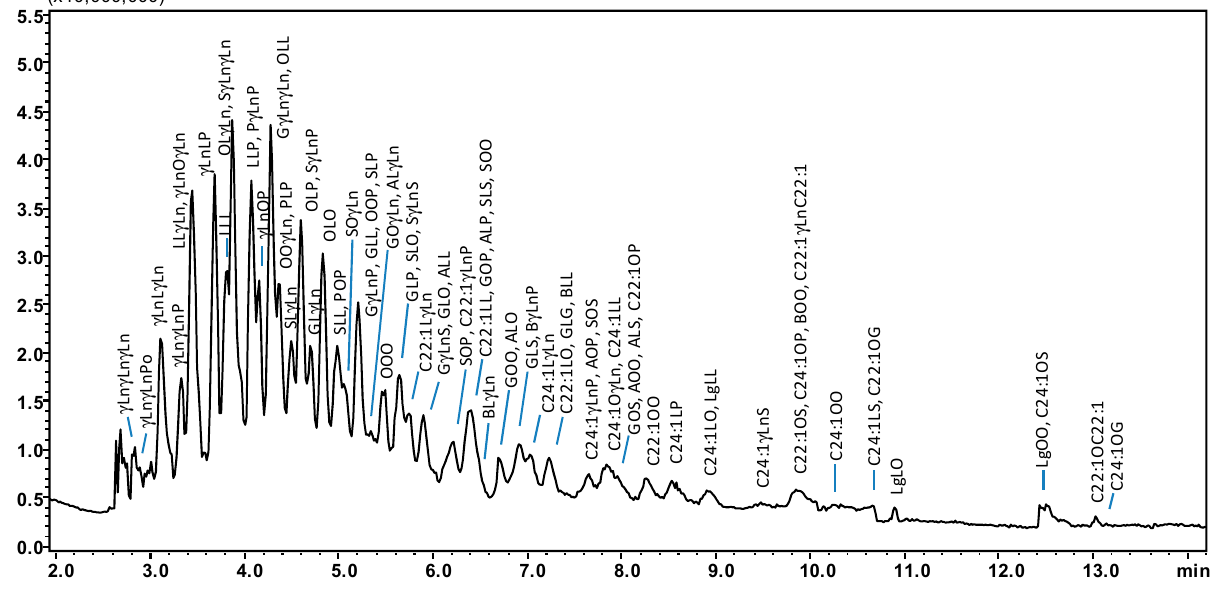
Figure 3. SubFC-APCI-MS TAG profile of a borage seed oil sample, employing a gradient of AcN into CO 2 . Column: Ascentis Express C18, 100 × 30 mm L × i.d., 2.0 μ m d.p., partially porous. Column temperature, 20 °C; ABPR, 150 bar and 50 °C; gradient elution of AcN into CO 2 , 0–5 min, 5% B, 5–15 min, to 20% B at 1.0 mL/min. Injection volume, 2.0 μ L. Peak labeling as in Table 1.